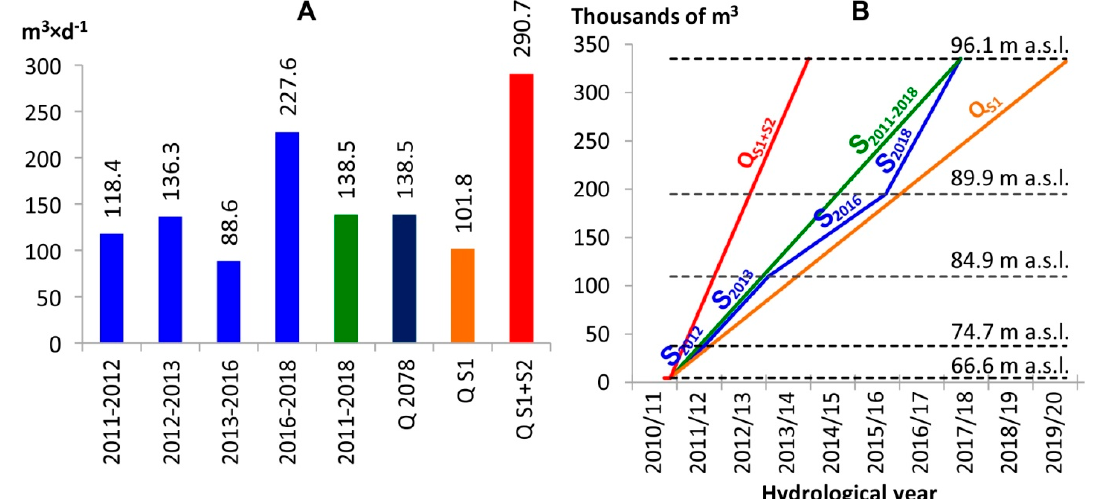
Figure 4. A is the average actual increase in retention in Strzelin I quarry lake in specific years (Table 2) and the calculated water supply (Q S1 , Q S1+S2 ). B is the sum curve of the actual retention increase (S) in the Strzelin I quarry lake during the period from 20 July 2011 to 20 January 2018 and the net calculated supply of Q S1 and Q S1+S2 . Table 2. Estimation results for the pace of filling the pit of the Strzelin I quarry with water .